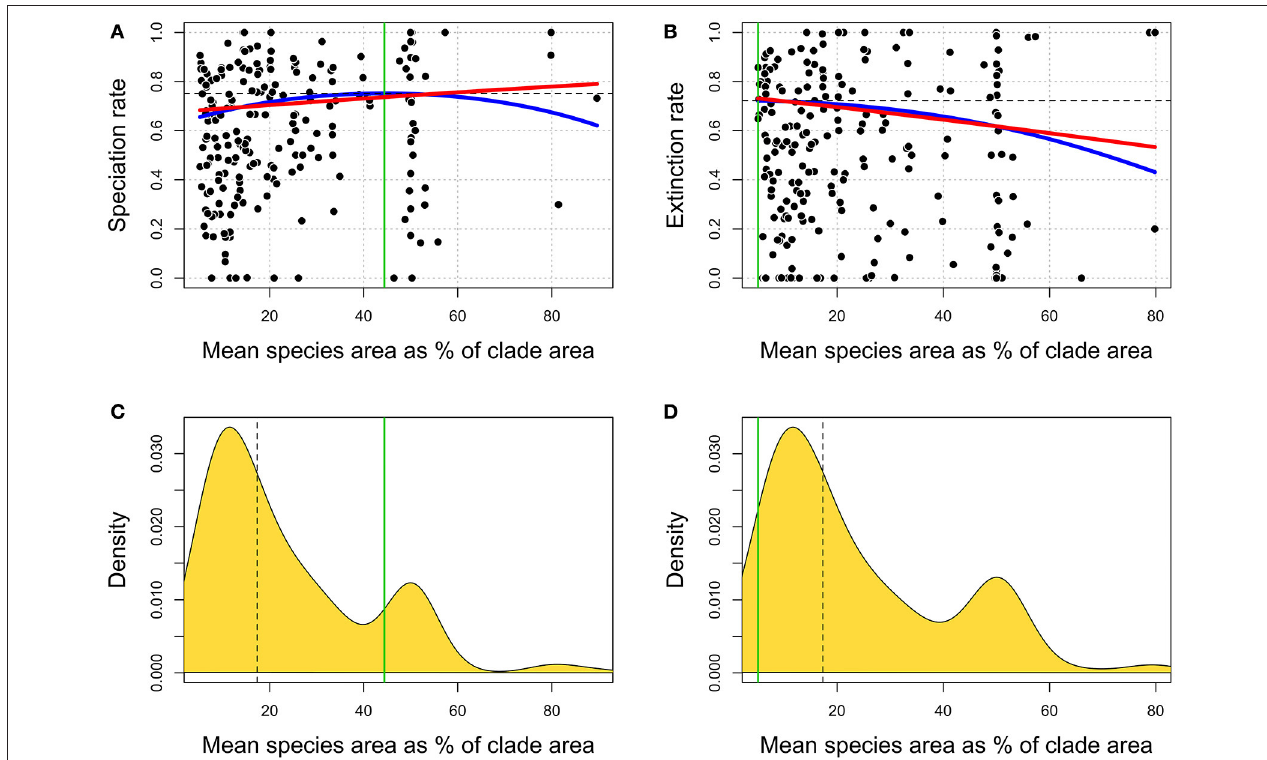
FIGURE 2 | Plot showing the fitted statistical models for both the speciation rate (left column) and the extinction rate (right). On the top, statistical relationships between speciation (A) and extinction rates (B) and SR. Blue lines refer to regression models including both linear and quadratic terms. Red lines indicate regression models including linear terms only. The green and the black dashed lines mark SR and diversification rates values where the quadratic regression models reach the inflection point. On the bottom, densities of SR values used as explanatory variables in regression models against speciation (C) and extinction (D) rates. Dashed black lines indicate the median value. Green lines mark SR values where the quadratic regression models reach the inflection